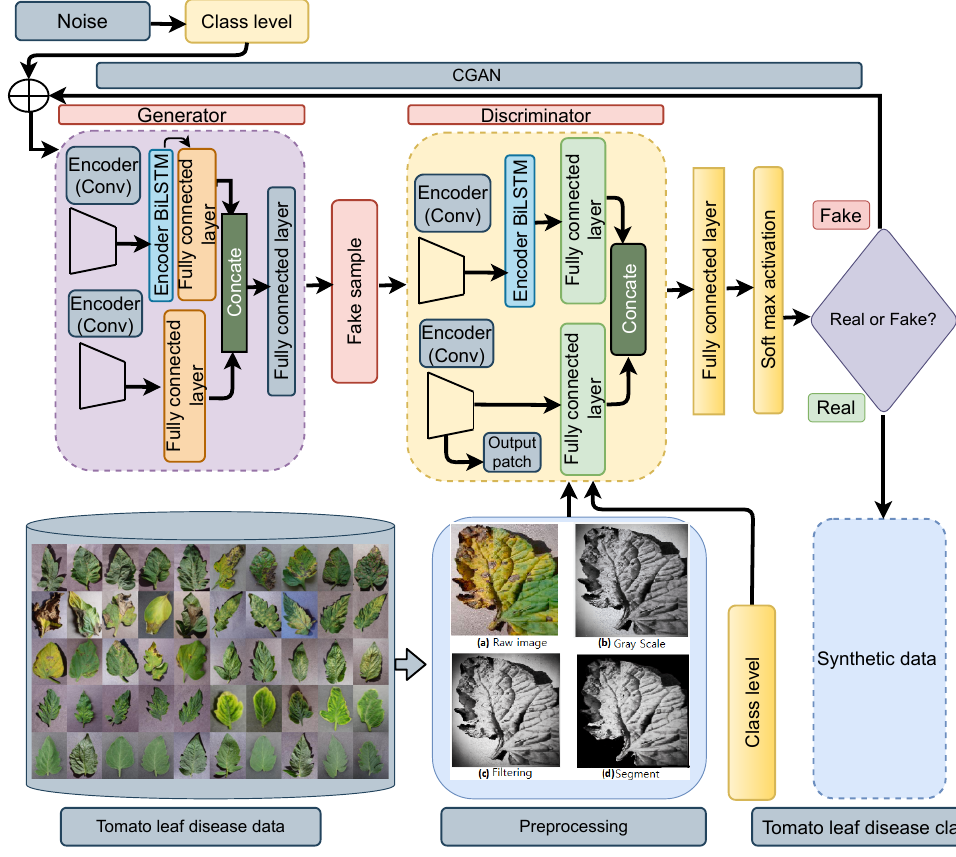
Figure 4. Synthetic Image Generation using